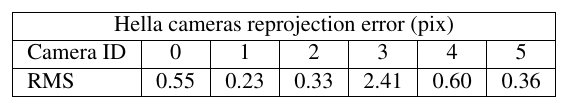
Table 2: Hella bundle adjustment results